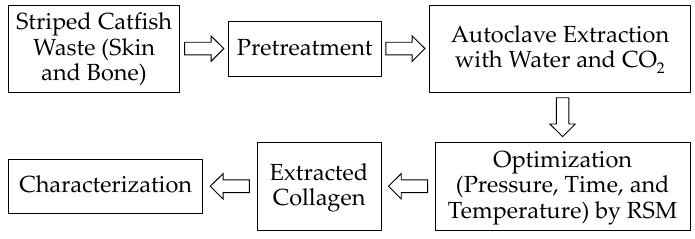
Figure 8. Schematic representation of experimental flow chart. Table 6. Experimental design range and values of independent